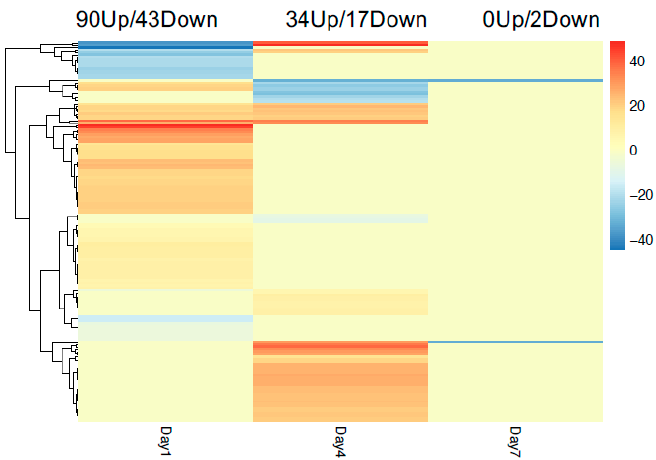
Figure 6. Heatmap of DEG on chromosome P9 between resistant and susceptible cultivars at 1, 4, and 7 days post-inoculation. Up(red) and Down(blue) regulated genes are those with significantly higher and lower expression in inoculated samples, respectively. The number of the legend indicates log2 fold change. Genes 2020 , 11 , x FOR PEER REVIEW 9 of 15